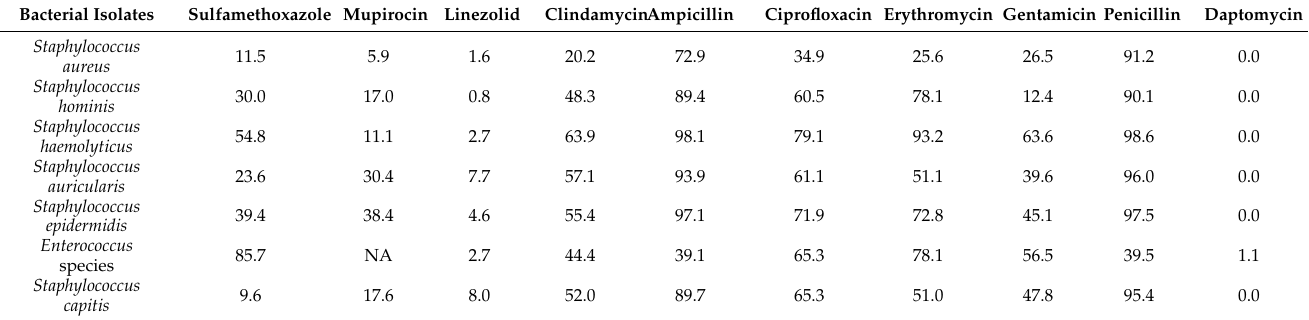
Table 9. Gram-positive bacterial susceptibility in patients aged more than 63